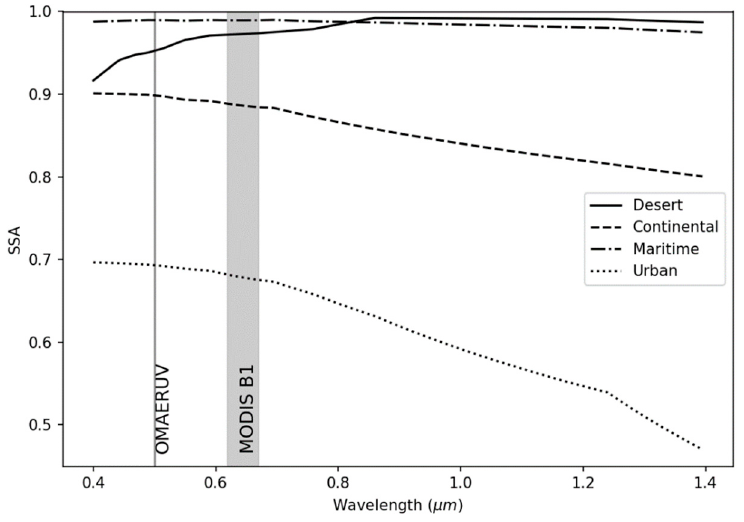
Figure 13. SSA values versus wavelength with different aerosol type.